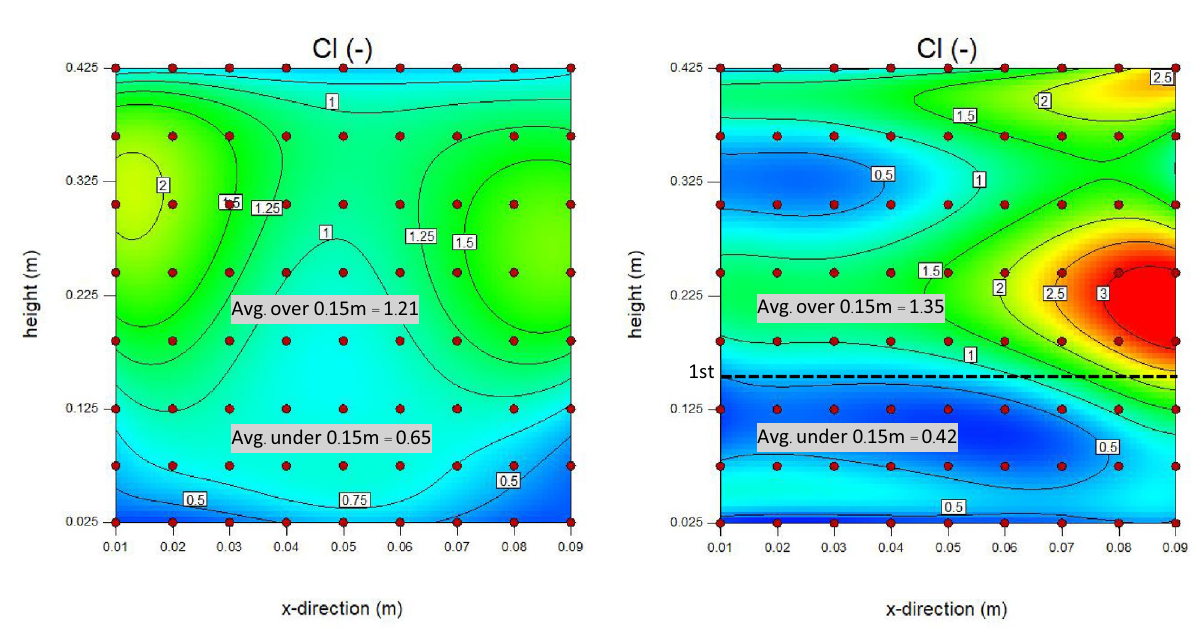
Figure 15. Contours of time-averaged local contact index (CI) in case of U g = 0.7